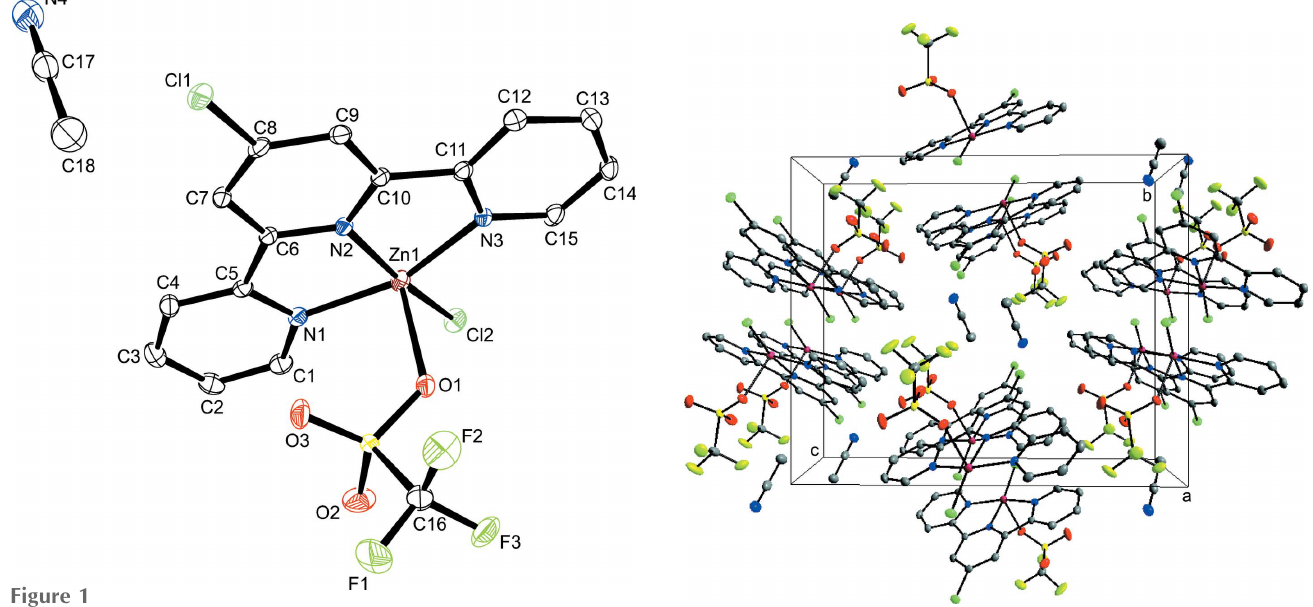
Figure 2 Perspective view of the packing structure of the title complex along the a axis.